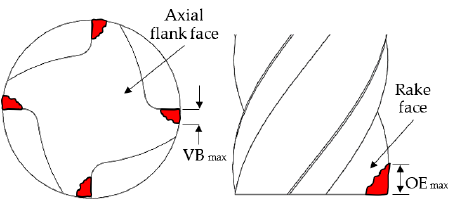
Figure 4. Schematic representation of measured types of tool wear (adapted from [22,37]).